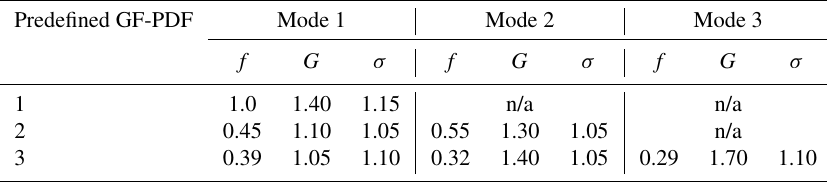
Table 1. Mode parameters of representative GF-PDFs for generating synthetic HFIMS